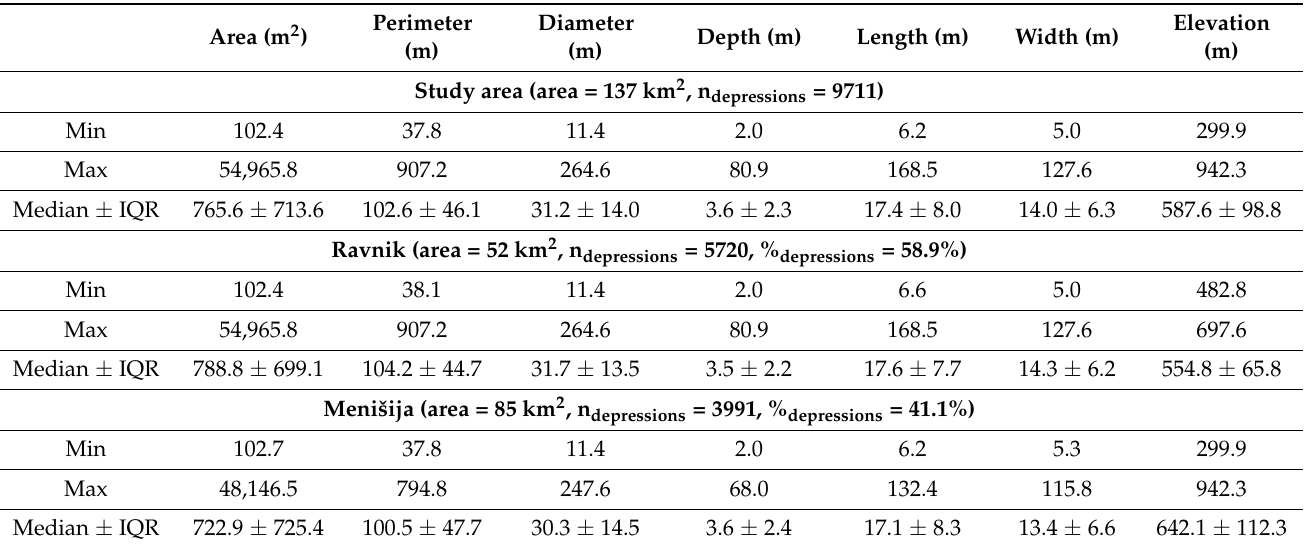
Table 1. Estimated minimum (Min) and maximum (Max) values for each morphometric characteristic considered, as well as median and interquartile range (Median ± IQR). Values are presented for the entire study area, and then separately for Ravnik and